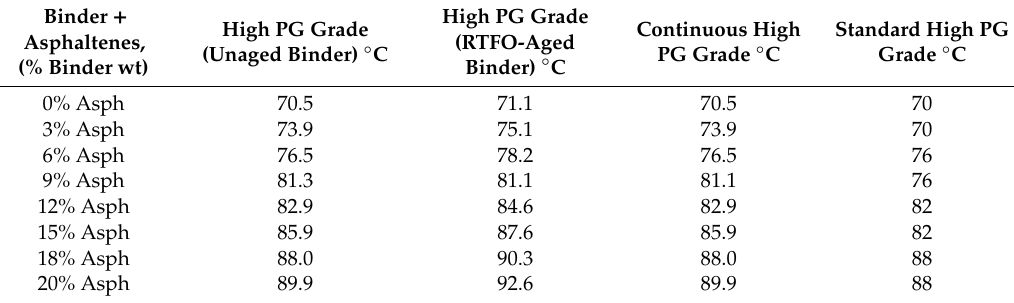
Table 2. High PG grading results for PG 70–22 modified with